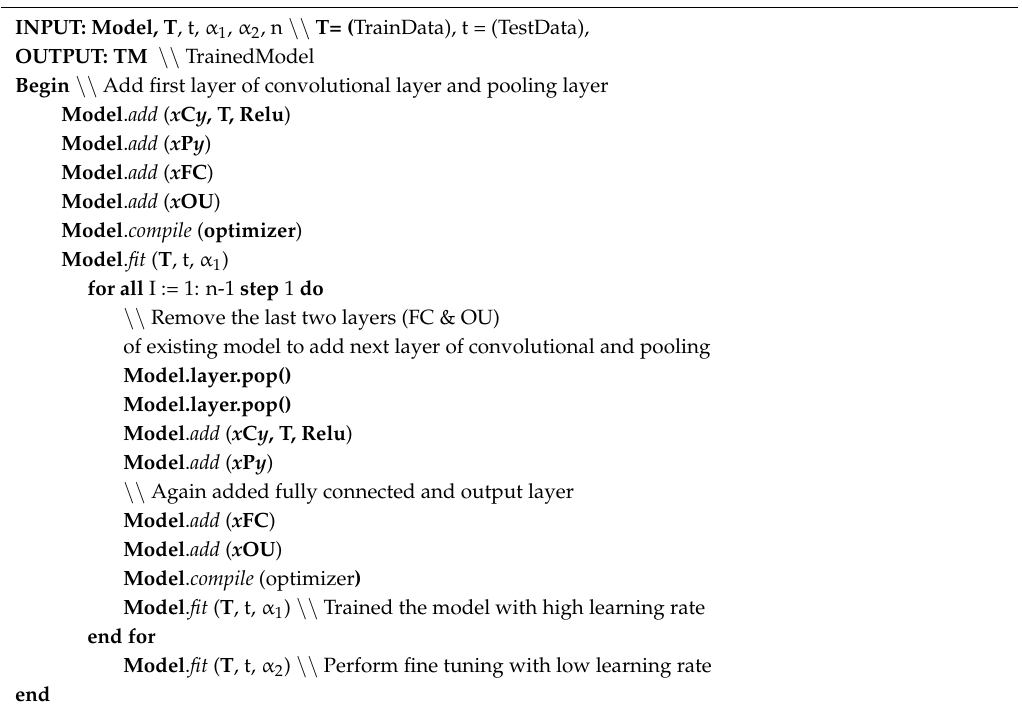
Figure 2. Layer-wise training of deep convolutional neural network. Algorithm 1. Layer wise training of deep convolutional neural network